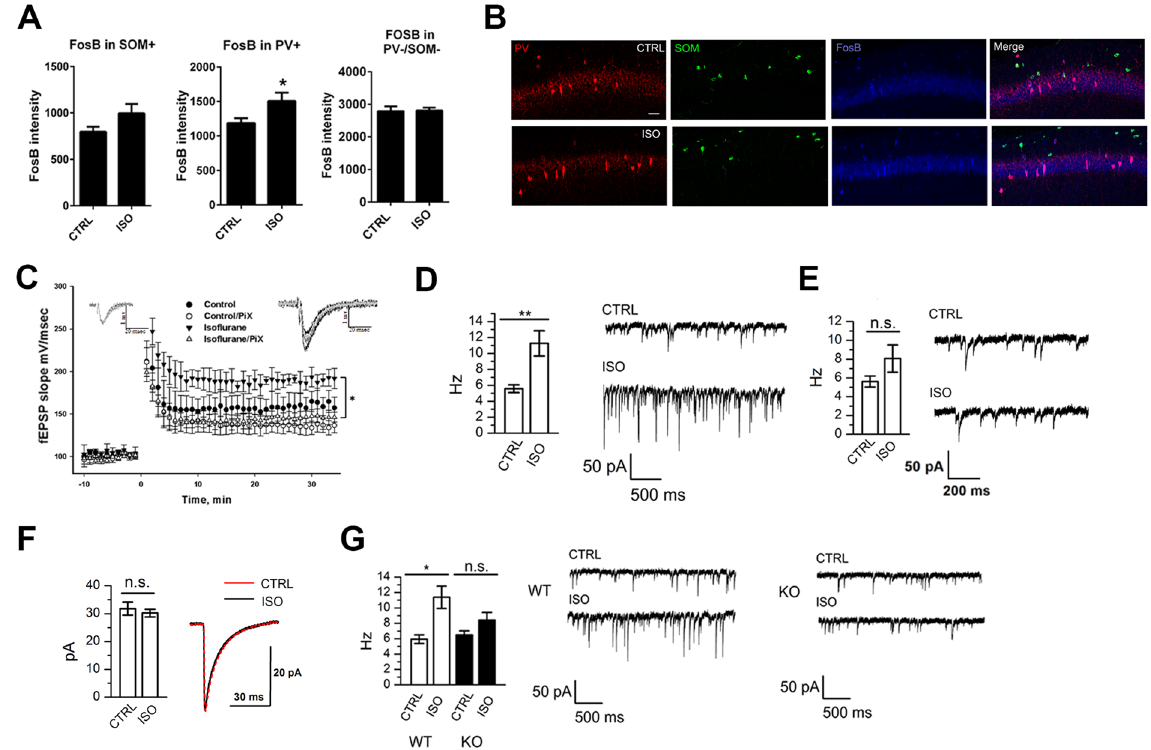
Figure 8. Isoflurane treatment leads to an increase in the activity of parvalbumin positive interneurons via activation of TrkB. ( A ) The intensity of FosB staining in parvalbumin positive (PV + ) cells, but not somatostatin positive cells (SOM + ) or cells not expressing PV or SOM (PV − /SOM − ), is significantly increased in the CA1 area of hippocampus of mice treated with isoflurane 24 hours before (p = 0.0474, Student’s t test). ( B ) Representative figures of the parvalbumin, somatostatin and FosB stainings. ( C ) Long-term potentiation (LTP) induced by high-frequency stimulation (HFS, 100 Hz) is enhanced in slices from mice treated with isoflurane for 30 min 24 hours before. The difference between the groups disappears in the presence of picrotoxin (PiX). Representative fEPSPs taken 5 min before and 30 min after the HFS are shown in the insets (control = black, isoflurane = dark grey; control/PiX = light gray; isoflurane/PiX = gray). ( D ) The average frequency of spontaneous IPSCs in CA1 hippocampal neurons recorded at 24 hours after isoflurane anesthesia (30 min) (6 slices/6 animals per group, ANOVA, p < 0.01) and example traces of the recordings. ( E ) The average frequency of miniature IPSC in CA1 hippocampal neurons (6 slices/6 animals per group, one-way ANOVA) is not affected by isoflurane treatment. ( F ) Decay time distribution of mIPSC (6 slices per group, Pearson’s χ 2 test). ( G ) The average frequency and example traces of spontaneous IPSC in CA1 hippocampal neurons recorded 24 h after isoflurane anaesthesia in wild-type (WT) and PV-TrkB + / − heterozygous (KO) mice (WT; 6 slices/6 animals for ISO, 5 slices/5 animals for CTRL; KO - PV-TrkB + / − ; 7 slices/7 animals for ISO, 5 slices/5 animals for CTRL; ANOVA, p < 0.05). Abbreviations: CTRL, control treatment; ISO, isoflurane treatment. * p < 0.05, ** p <